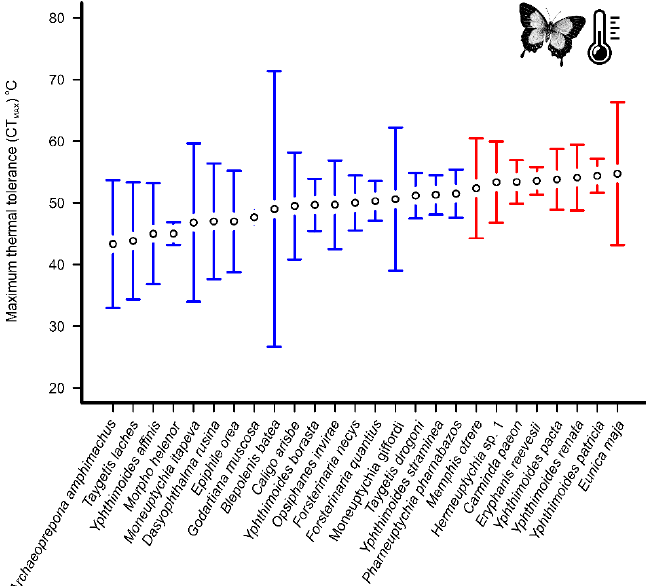
Figure 2. Mean of maximum critical temperature (CTmax) in °C per specimen of fruit-feeding butterflies sampled in the mountaintop environments. Species with higher thermal tolerances are shown in red. The bars represent 95% confidence interval.